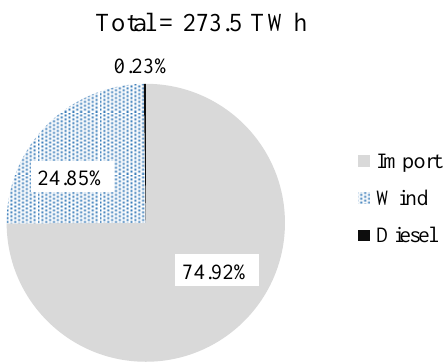
Figure 2. Summerside energy supply between August 2016 to August